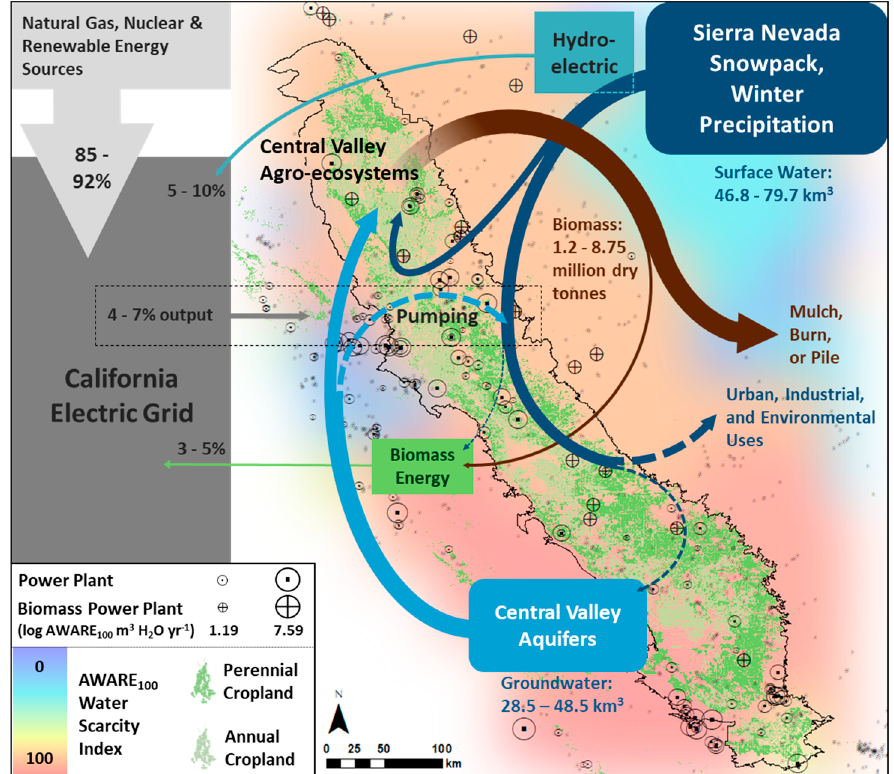
Figure 2. The food-energy-water nexus in California’s Central Valley growing region. When surface water delivery is reduced, as during the 2011–2016 drought, a greater proportion of agricultural water is drawn from groundwater sources, resulting in greater energy requirements and cost to growers—potentially causing reduction in applied water and subsequent agronomic consequences. The quantity of water recharging aquifers either deliberately, or via environmental use, is uncertain, and as such, is represented by a dashed line. Value ranges represent data from wet (2006) and dry (2014) years. Almond orchards produce biomass co-products commonly used as an energy feedstock, in the form of EoL tree removals and shells from post-harvest operations. Electric grid data from [10], biomass data from [11], and water application data from [12,13].